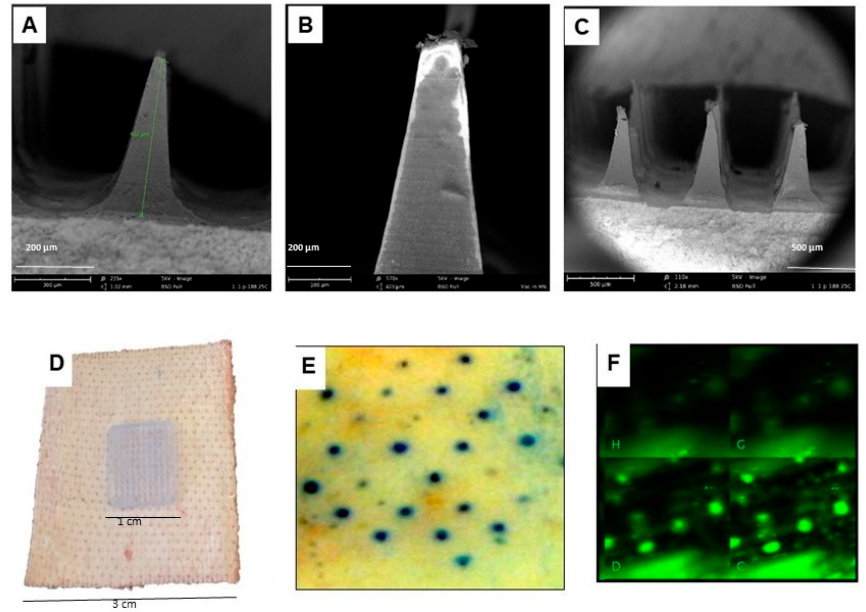
Figure 4. Scanning electron microscopy (SEM) image of the N. gonorrhoeae vaccine microparticles